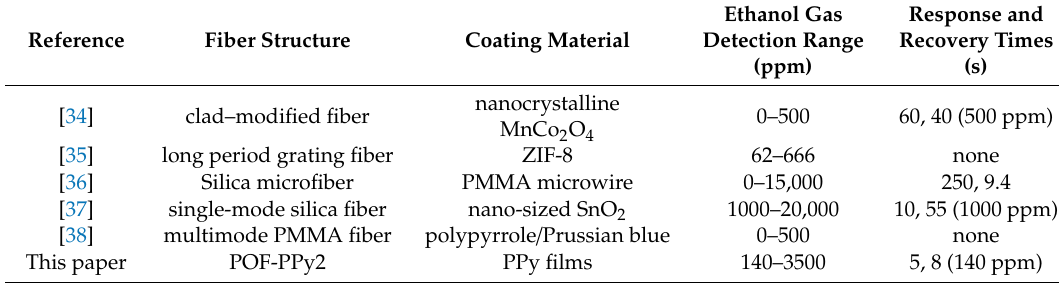
Table 1. Comparison of the proposed sensor and the cited sensors.